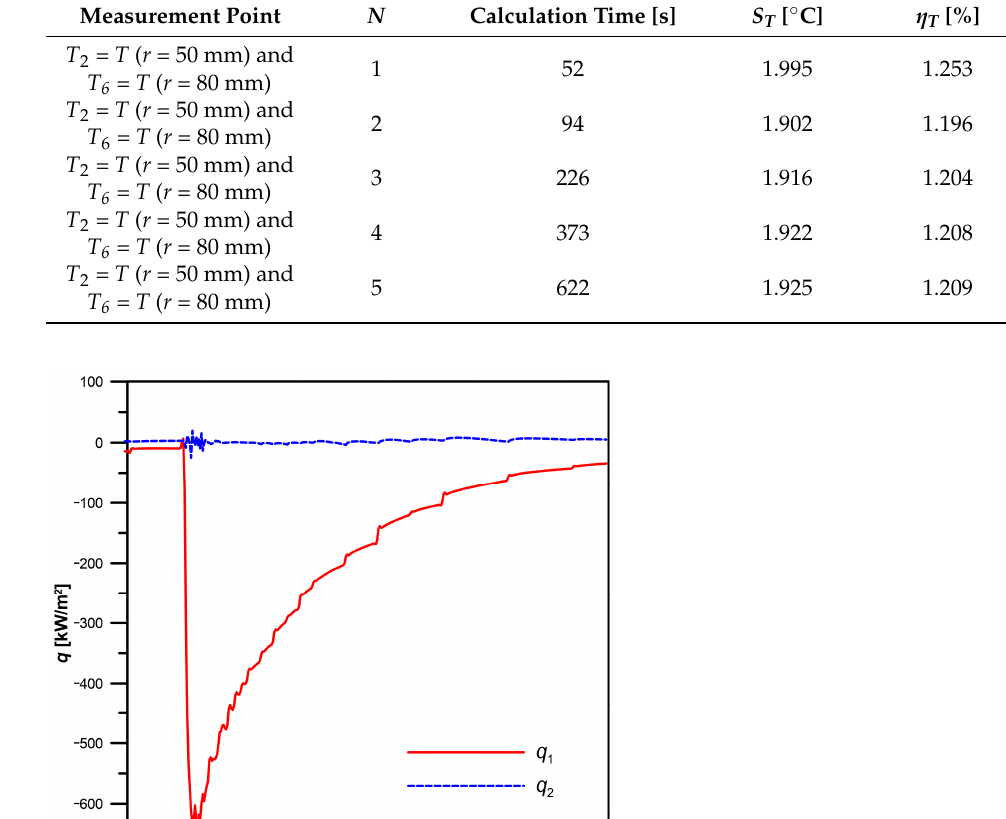
Table 5. Calculation time and errors obtained by the AMI method for two measurement points.